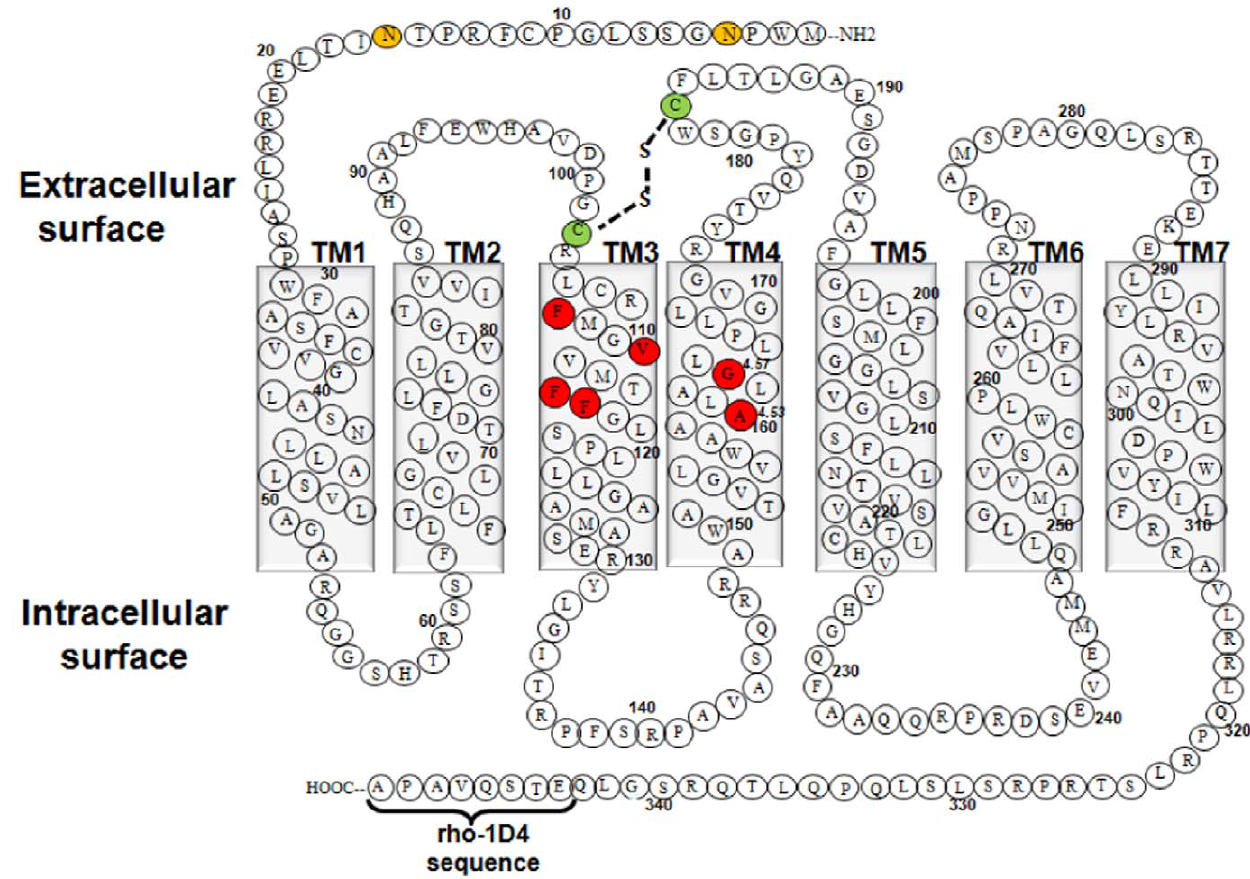
Figure 1. Two-dimensional representation of the TP a amino acid sequence. Amino acids are shown in single-letter codes. Shown are the seven transmembrane helices, the disulphide bond between the Cys102 and Cys183 (green colored residues), the N-glycosylated residues Asn4 and Asn16 (orange colored residues), and the rho-1D4 octapeptide epitope tag at the C-terminus. The two conserved residues Ala160 4.53 and Gly164 4.57 on TM4 along with the residues on TM3 mutated in this study are shown in red.